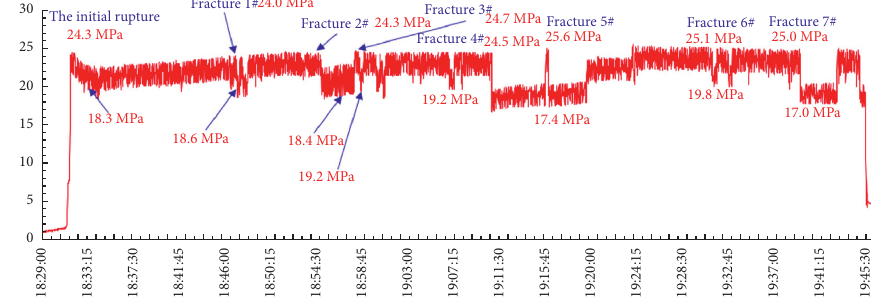
Figure 20: Analysis of the fracturing effect.